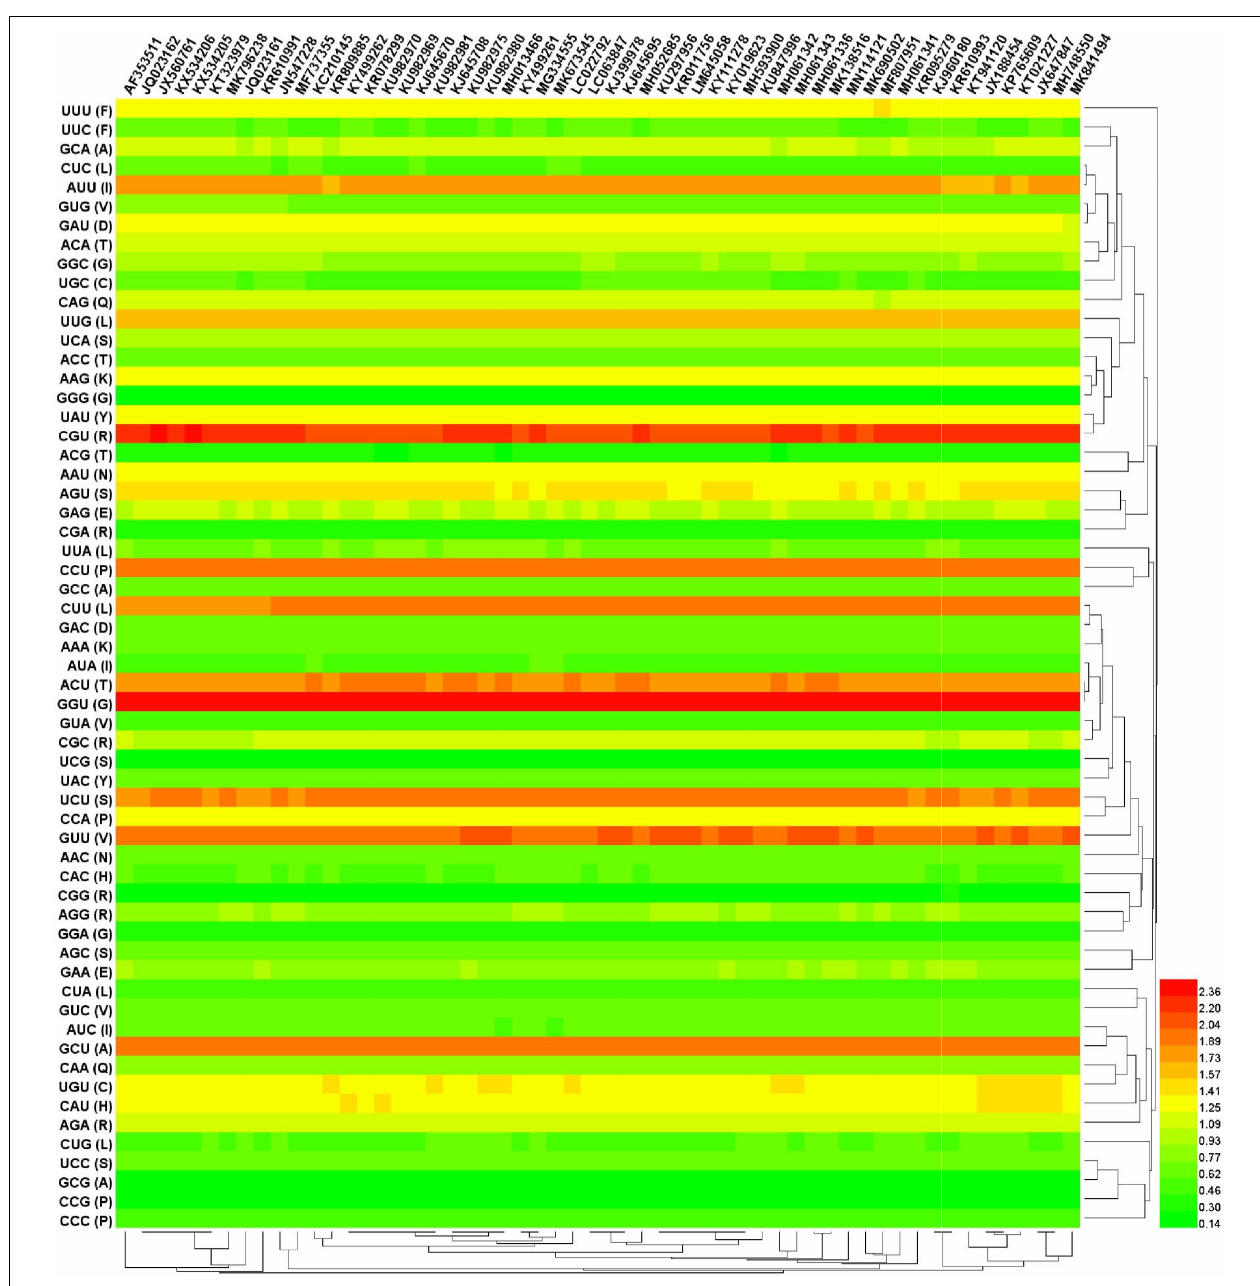
FIGURE 2 | Cluster analysis (Heat map) of RSCU values among overall 56 complete coding region. The heat map represents the RSCU values divided into 3 ranges: < 1 (Green color), 1–1.6 (Yellow color), and > 1.6 (Distinct red). The heatmap analysis was performed using CIMminer. Each column represents a codon. The higher RSCU value, suggesting more frequent codon usage, was represented with distinct red. The codon usage is highly biased toward A/U-ending codons. Euclidean distance and complete-linkage methods were used to produce the